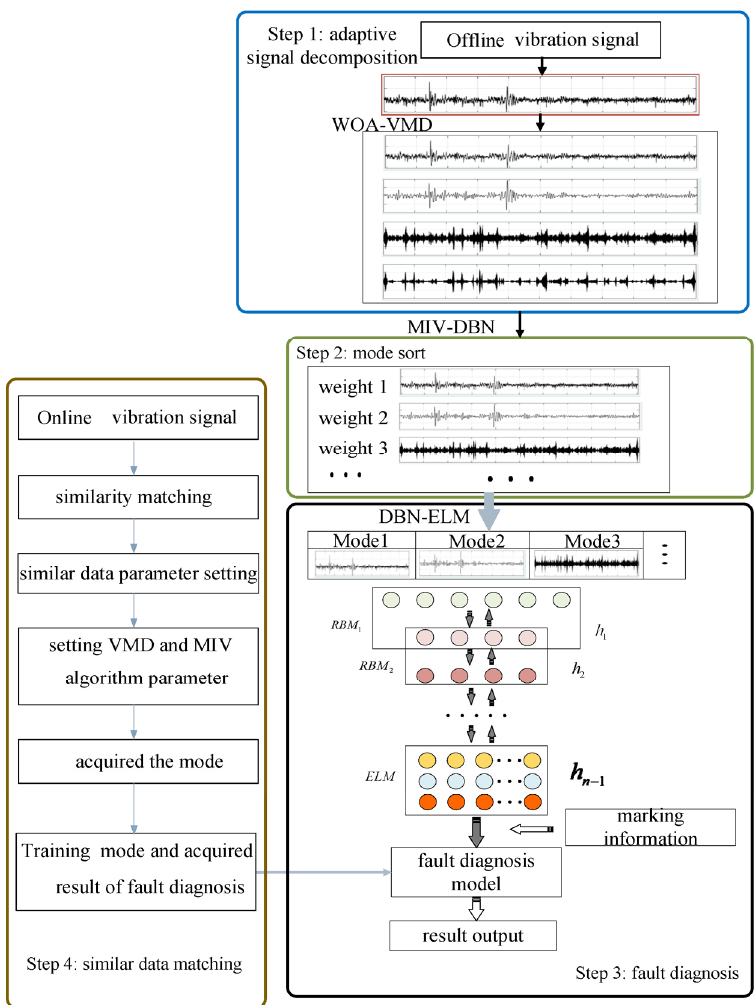
Figure 4. The structure of adaptive VMD and mode sort based DBN-ELM algorithm.